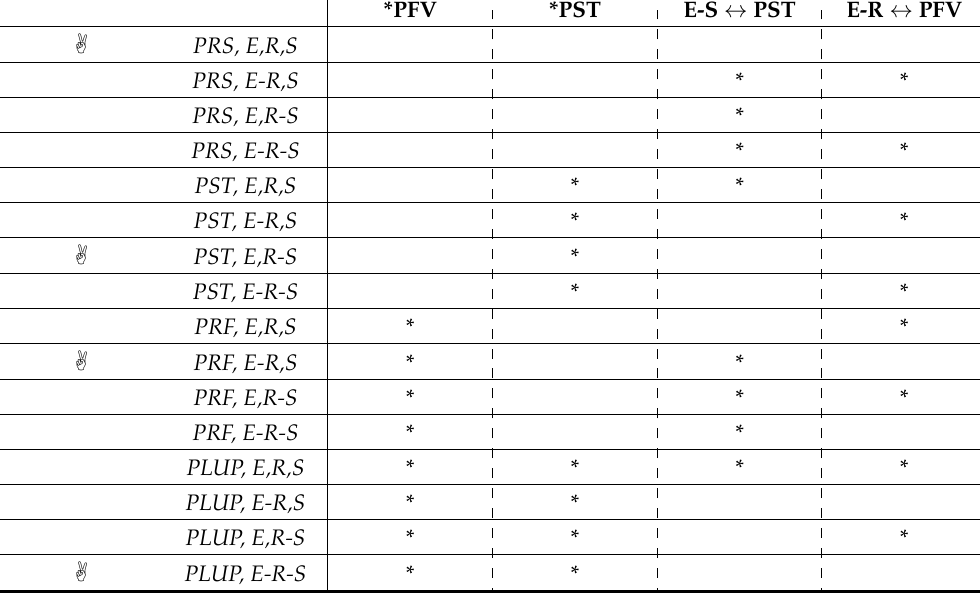
Tableau 1. Bidirectional optimization of